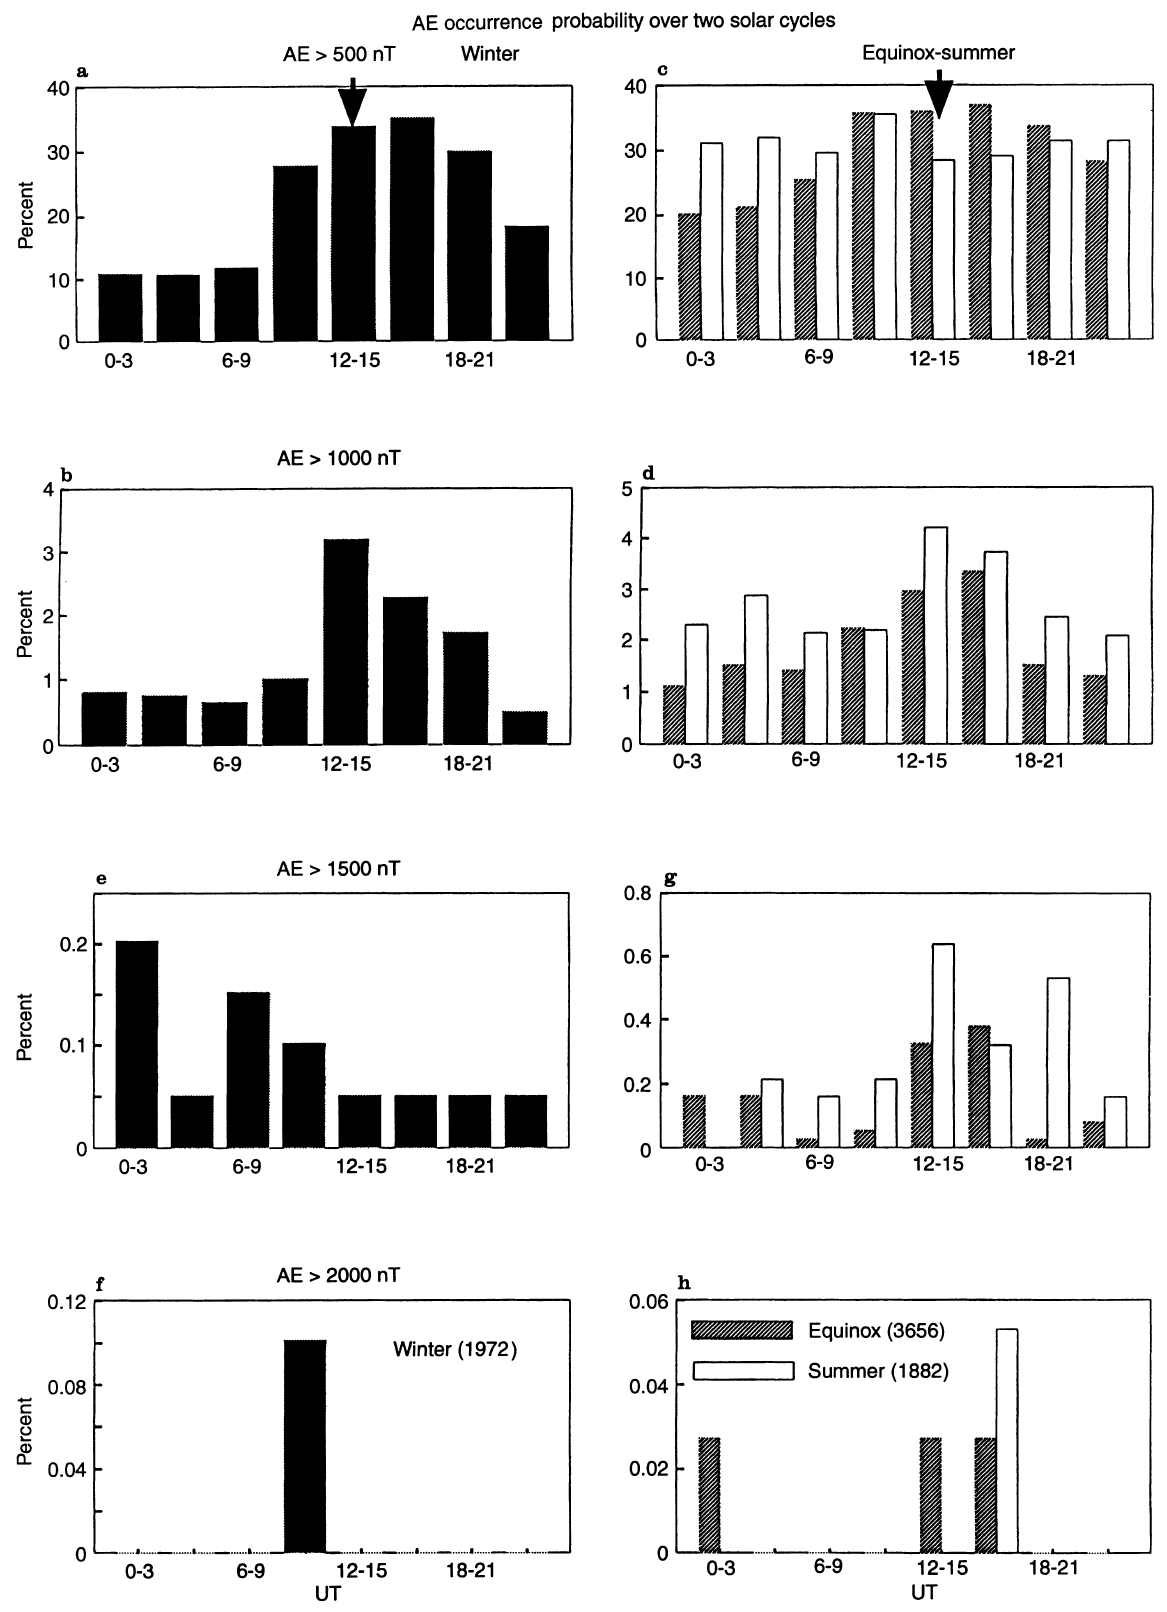
Fig. 7a–h. Probabilities of occurrences of the indicated AE-index values for the two solar cycles and for di(cid:128)erent seasons. The numbers of days used in the analysis for each season are indicated in the